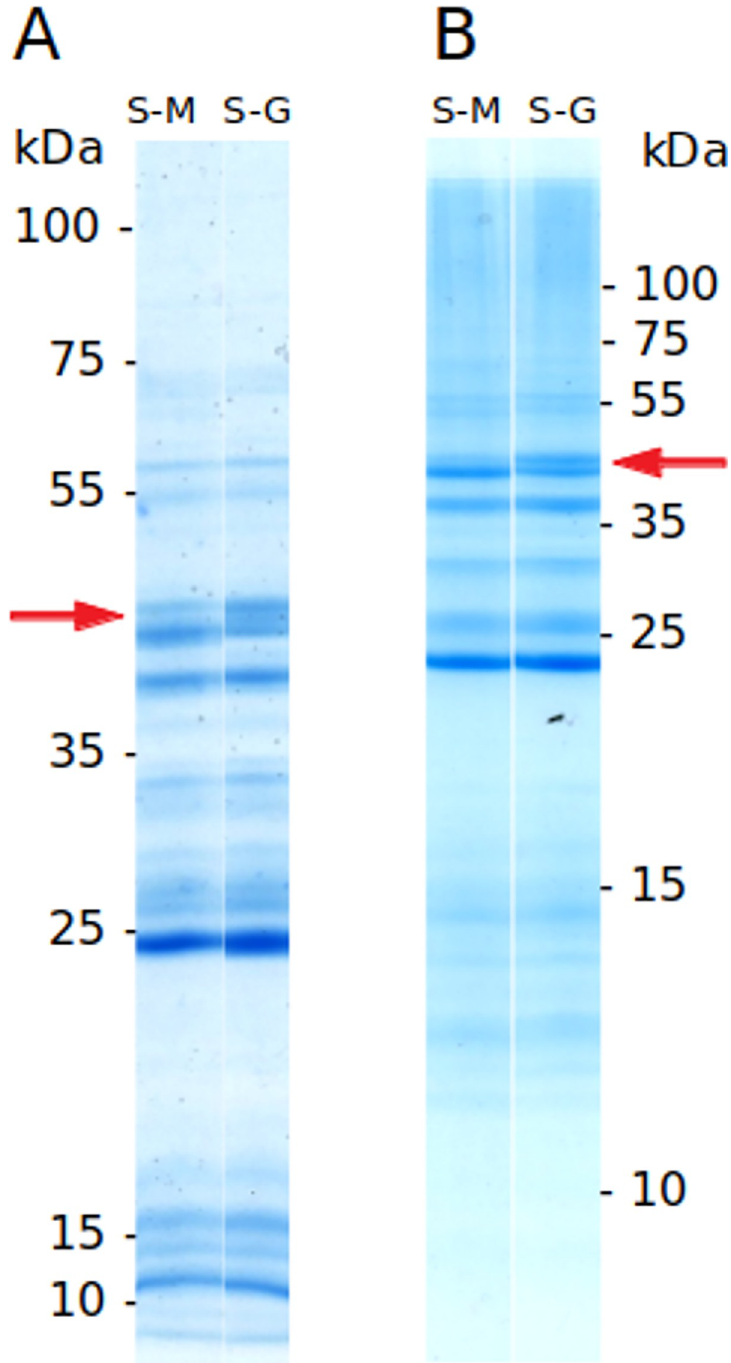
Fig 12. Salivary glands proteins from two S . schwetzi lineages maintained on different blood-meal sources geckos (S-G) and mice (S-M): SDS PAGE electrophoresis under reducing conditions. (A) separation on 10% polyacrylamide gel, (B) separation on 15% polyacrylamide gel. Molecular weights in kilodaltons are indicated and red arrow marks the band 40–45 kDa.